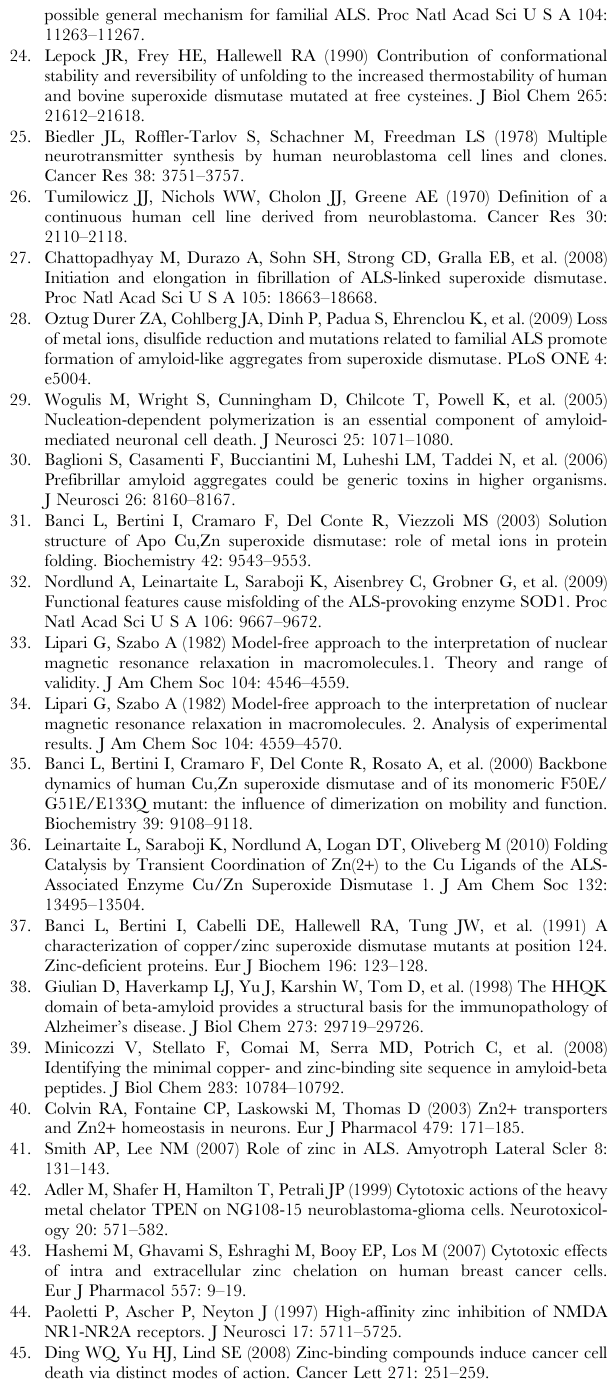
Figure S5 Monomeric apoSOD1 induces toxicity also under serum free conditions. Cells were incubated with monomeric apoSOD1 in cell media without serum or under standard conditions, i.e. media supplemented with 0.5% serum. Cell viability was measured using the MTT assay. Proteins were added in duplicate and data are presented as mean and range as percentage of the buffer control. The effect of apoSOD1 on cells with or without serum is of a similar